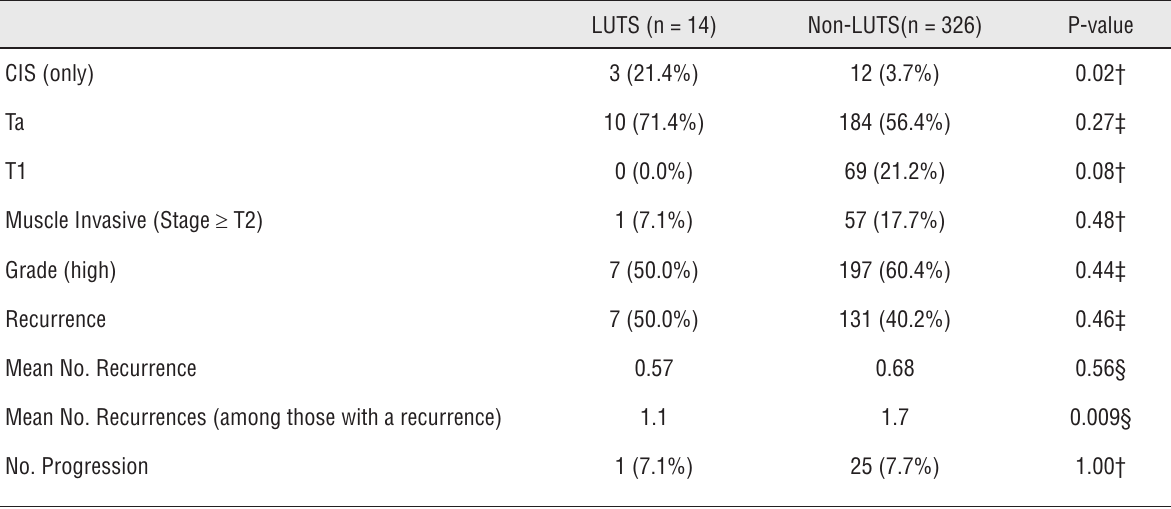
Table 2 - Pathologic Characteristics for LUTS and Non-LUTS patient